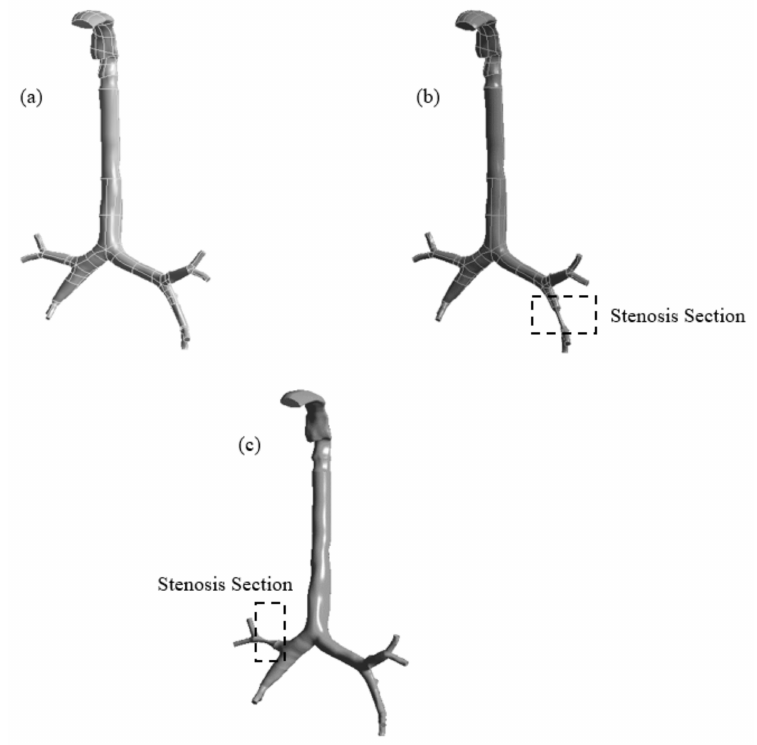
Figure 1. Reconstructed models of the mouth–throat and tracheobronchial airways: ( a ) healthy, ( b ) stenosis airway in the right lung, and ( c ) stenosis airway in the left